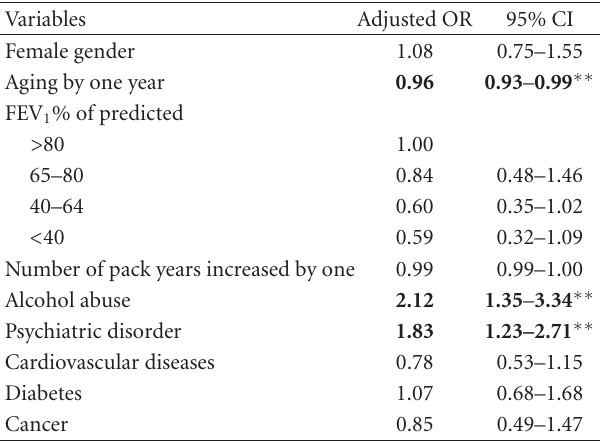
Table 2: Independent risk factors for failure in smoking cessation by multivariate logistic regression